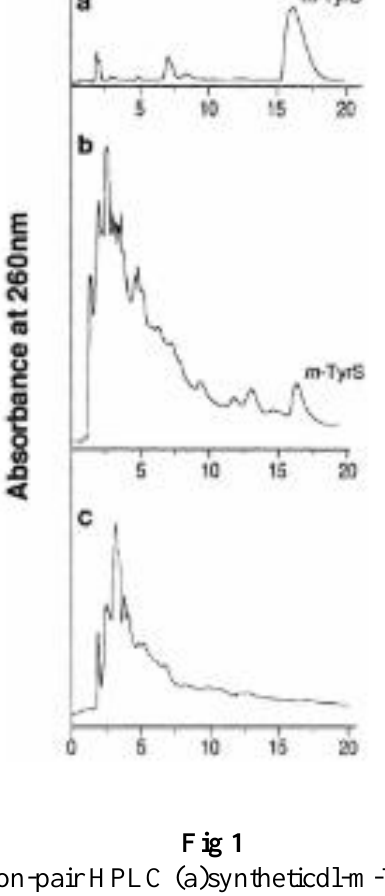
Ion-pair HPLC (a)syntheticdl-m-TyrS and (b)